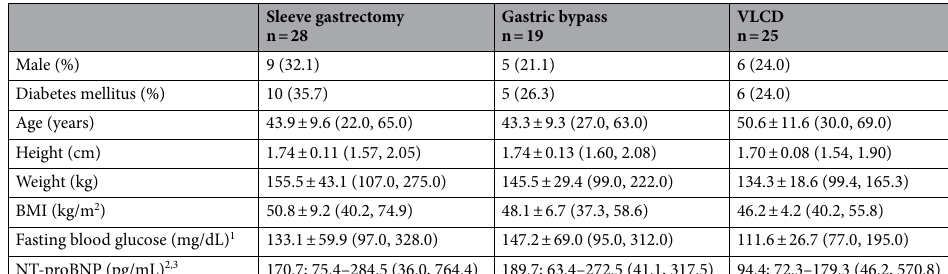
Table 1. Baseline characteristics of intervention groups. Values are presented as mean ± SD for continuous variables or number (frequency) for categorical variables with minimum and maximum in parentheses. 1 Only complete and valid fasting blood glucose values were included in the analysis (sleeve gastrectomy: n = 14, gastric bypass n = 9, VLCD: n = 25). 2 Skewed values are expressed as medians with interquartile ranges separated by a hyphen and with minimum and maximum in parentheses. 3 Only NT-proBNP values above the ELISA detection limit were included in the analysis (sleeve gastrectomy: n = 14, gastric bypass n = 7, VLCD: n = 9). BMI, body mass index; NT-proBNP, N-terminal pro brain natriuretic peptide; VLCD, very low-calorie